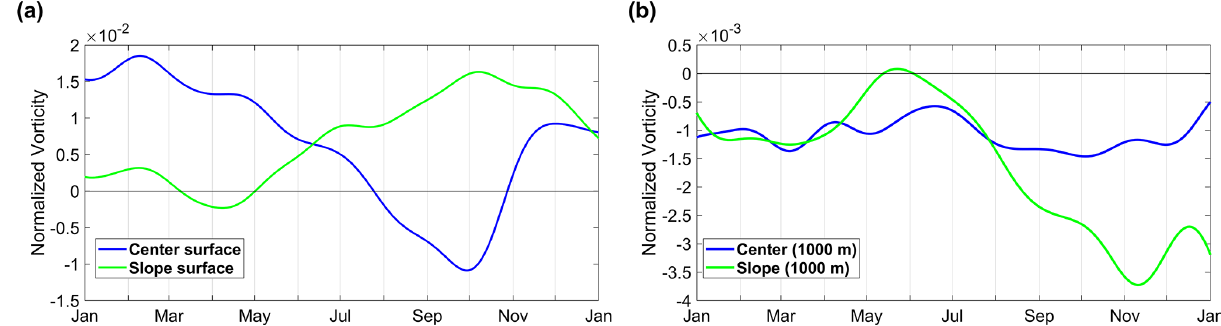
Figure 11. The northern Ionian Sea in 2012: temporal evolution of the vorticity normalized by the Coriolis parameter f (10 − 4 s − 1 ) in the surface (a) and deep (b) layers (1000m depth) of the slope and in the center. Please note the different scales of the surface (a) and deep (b) vorticity